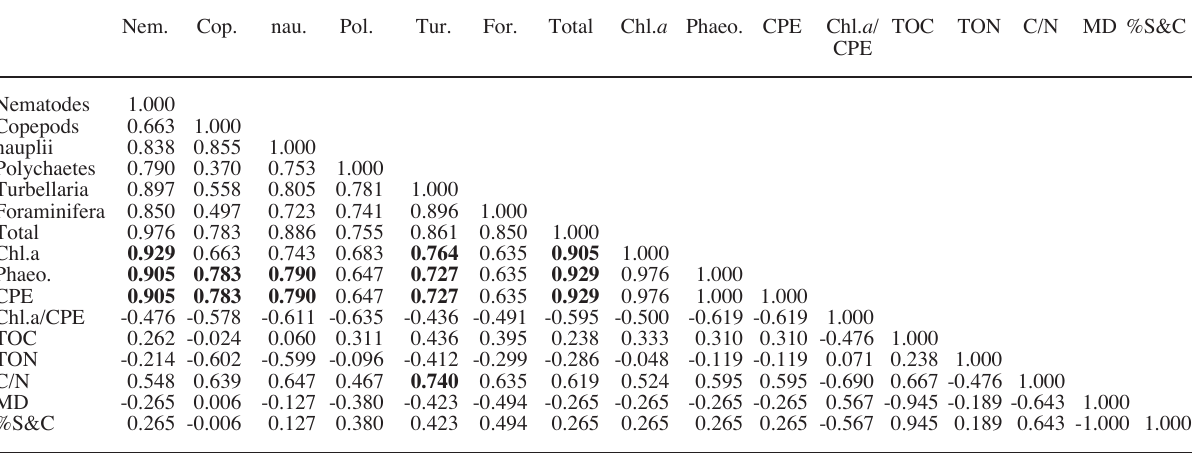
T ABLE 4. – Spearman Correlation Coefficients between meiobenthic abundances and sedimentary parameters at the stations of 1500-1700 m depth (P ≤ 0.05). Nem., nematodes; Cop., copepods; nau., nauplii; Pol., polychaetes; Tur., Turbellaria; For., Foraminifera; Total, total meioben- thos; Chl. a , chlorophyll a ; Phaeo., phaeopigments; CPE, chloroplastic pigment equivalent; Chl. a /CPE, ratio of Chl. a to CPE; TOC, organic car- bon; TON, organic nitrogen; C/N, carbon to nitrogen ratio; MD, medium diameter of sediment; % S&C, percentage of silt and